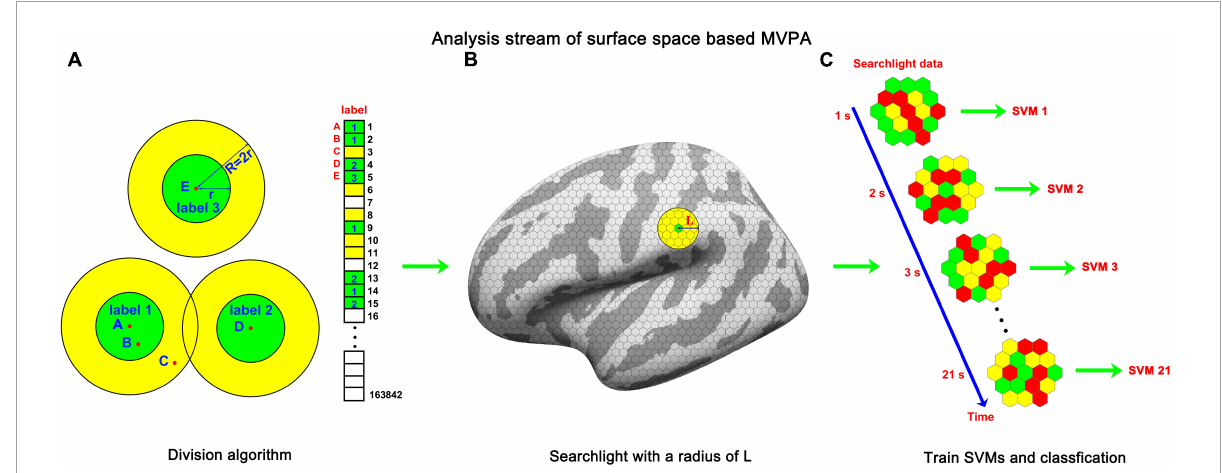
FIGURE2 The analysis stream of sf-MVPA. (A) Double radius dividing method. We used this method to divide the template of fsaverage into labels as evenly as possible. Dividing was implemented according to the numerical order of the vertices. For a vertex (e.g., points A, D, and E) that was not grouped into a label, the vertices whose distances from the vertex were shorter than r were grouped into a label and painted green. The vertices whose distances from the vertex were longer than r but shorter than R (R = 2r) were painted yellow. For vertices that were painted color (e.g., points B and C) by the painting process of the former vertices, the painting and grouping process was forbidden. The large circle guarantees that the labels will not overlap. After the iteration process, the vertices painted yellow were grouped into the nearest label. (B) Searchlight on the surface space. The grid on the surface represents the labels. The yellow circle represents the searchlight. (C) The frame-by-frame training and classification process. The hexagons represent labels and the color on them represents the averaged strength of BOLD